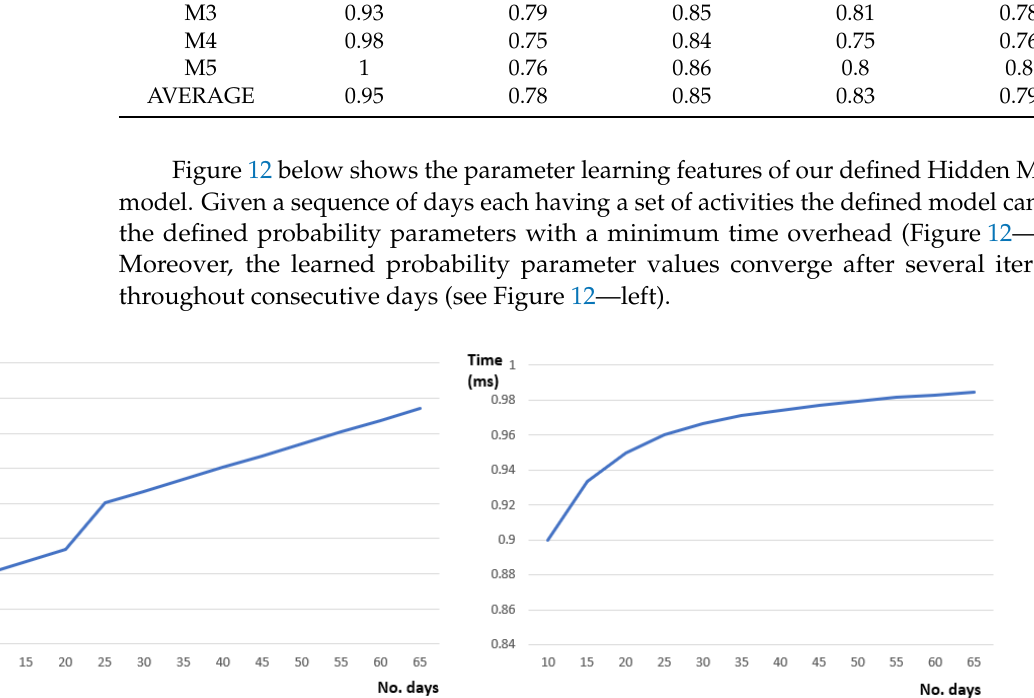
Table 4. Cross-validation evaluation results.